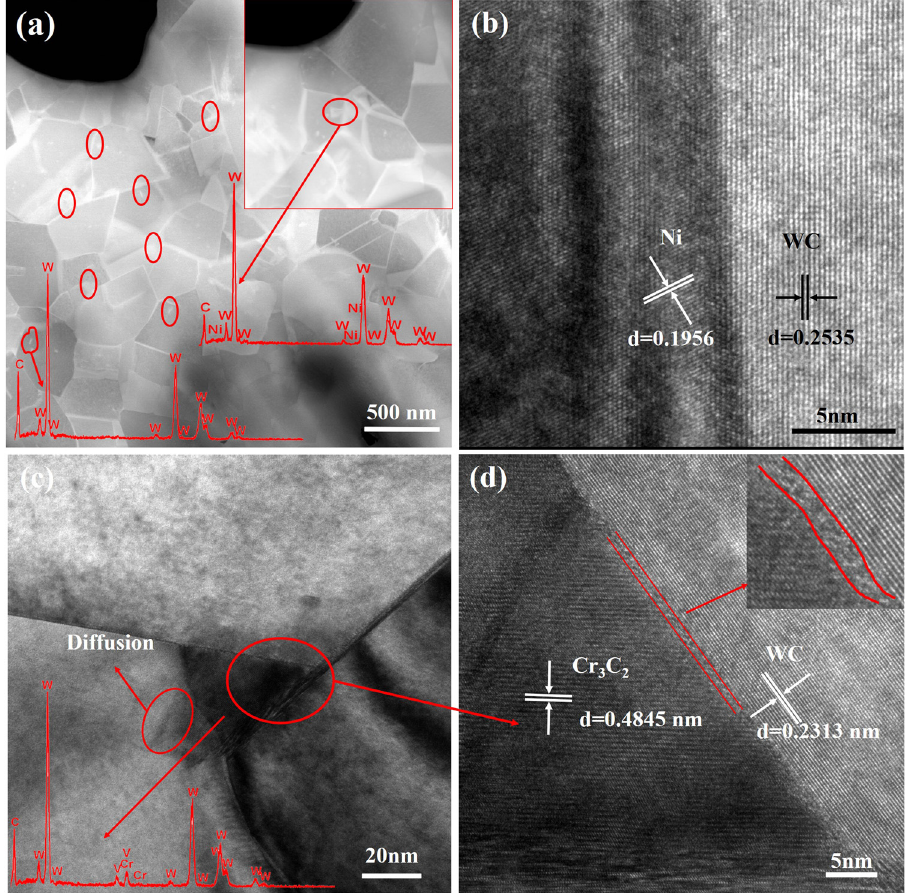
Figure 6: ( a ) TEM results of the topography, ( b ) TEM results between WC and Ni, and ( c and d ) TEM results between WC and Cr 3 C 2